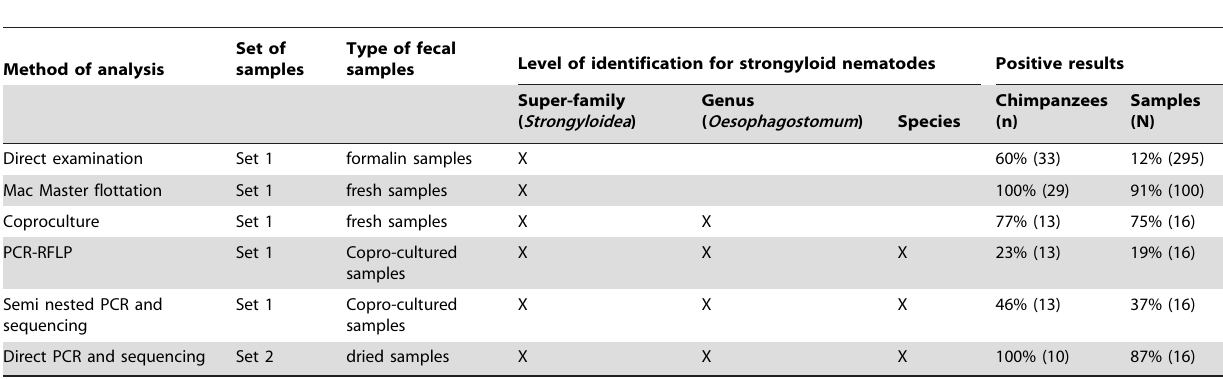
Table 1. Analyses for Oesophagostomum sp. identification from fecal samples of wild chimpanzees collected in two periods.